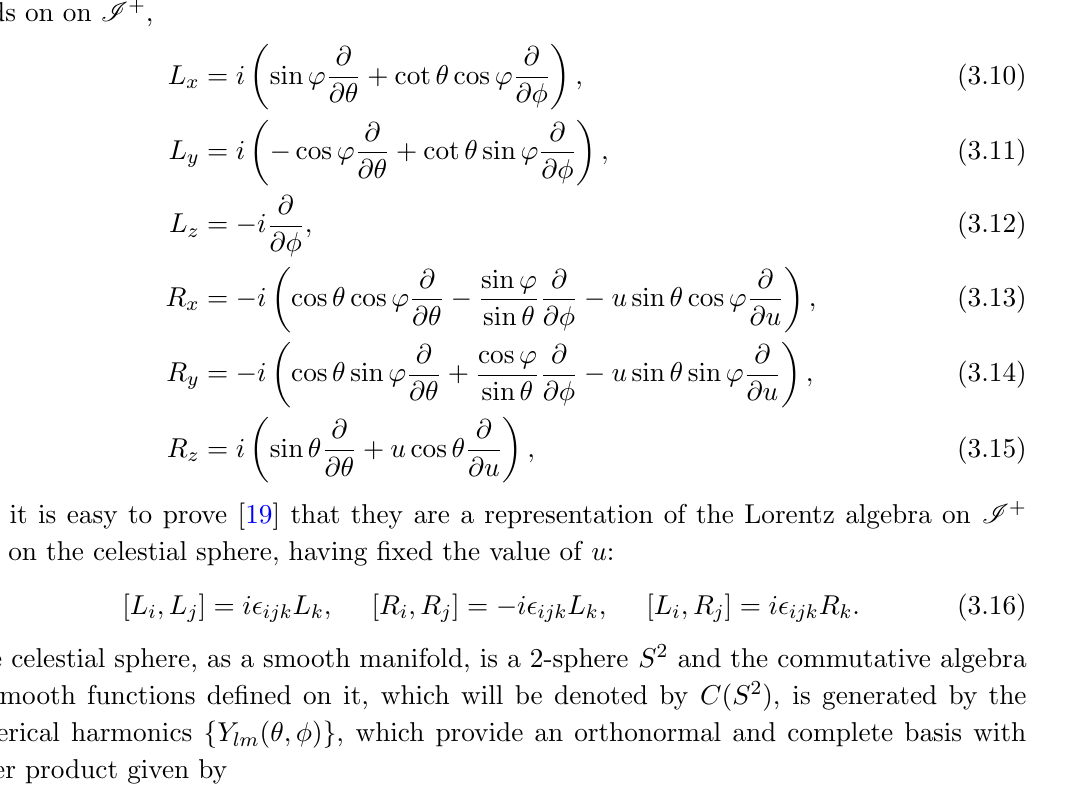
j = j (cid:16) i j = e (cid:0) (cid:31) i